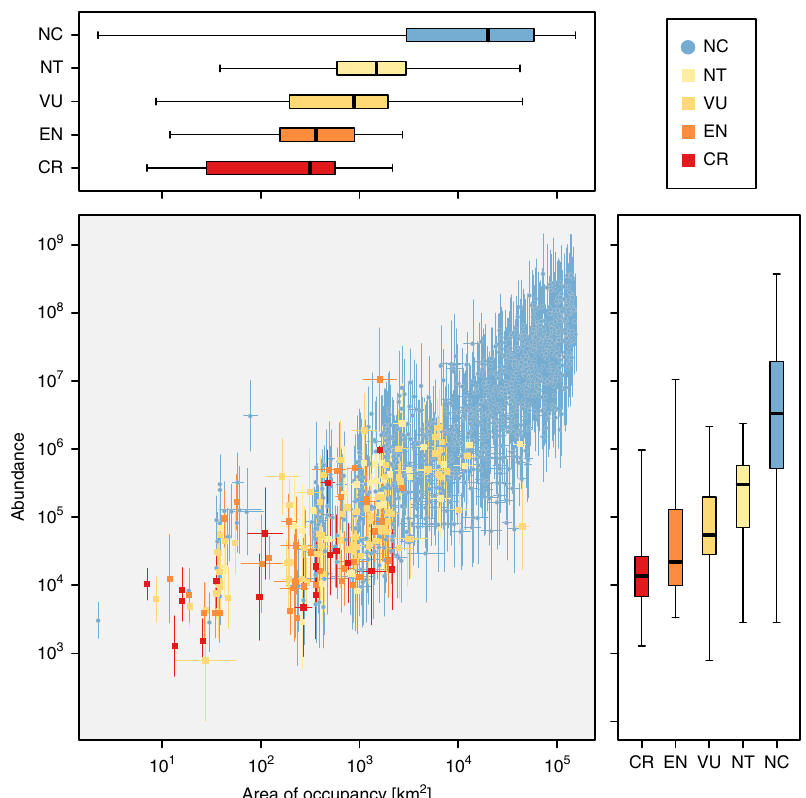
Fig. 5 Abundance and area of occupancy of woody plant species in natural forests in Japan, with relation to their national red list categories. NC not classi fi ed; NT near threatened; VU vulnerable; EN endangered; CR critically endangered. Error bars in the scatter plot indicate standard errors. Box plots: middle line, median; box, fi rst and third quartiles; whiskers, minima and